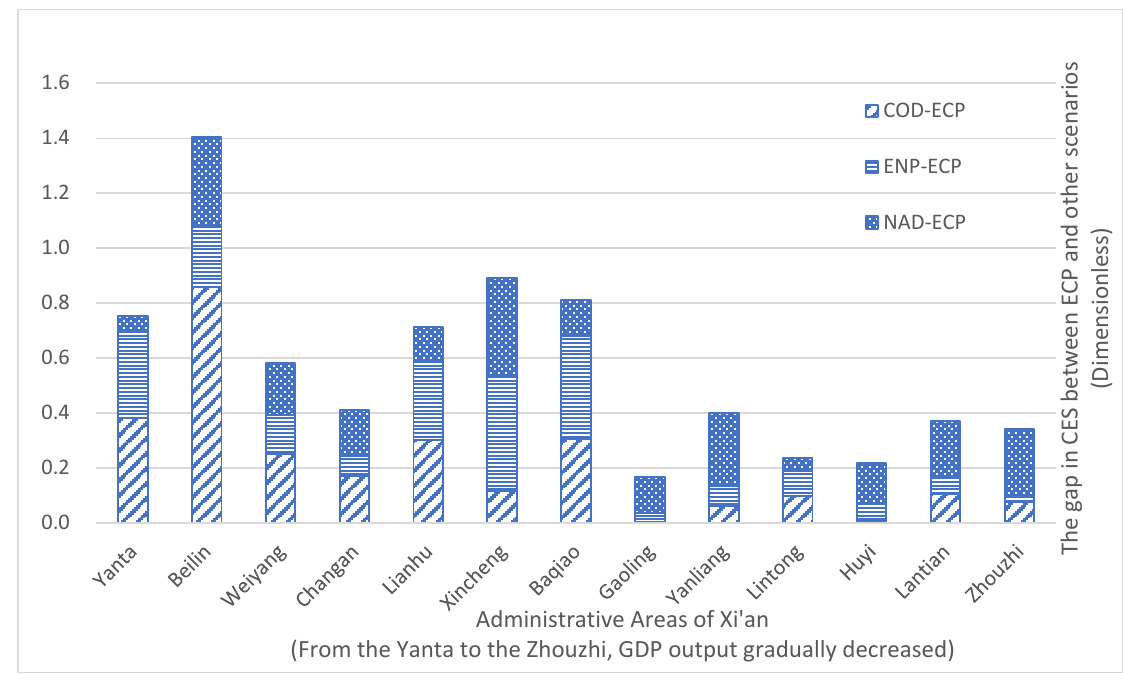
Figure 6. The impact of the economy on different administration district.